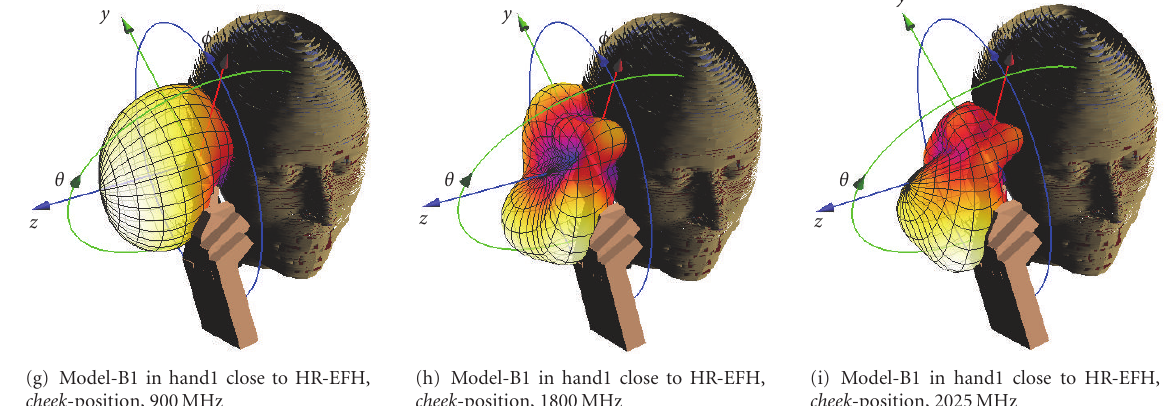
Figure 6: The three-dimensional far-field radiation beam patterns of the handset model-B1 in free space, in hand1 close to SAM and in hand1 close to HR-EFH at 900, 1800, and 2025